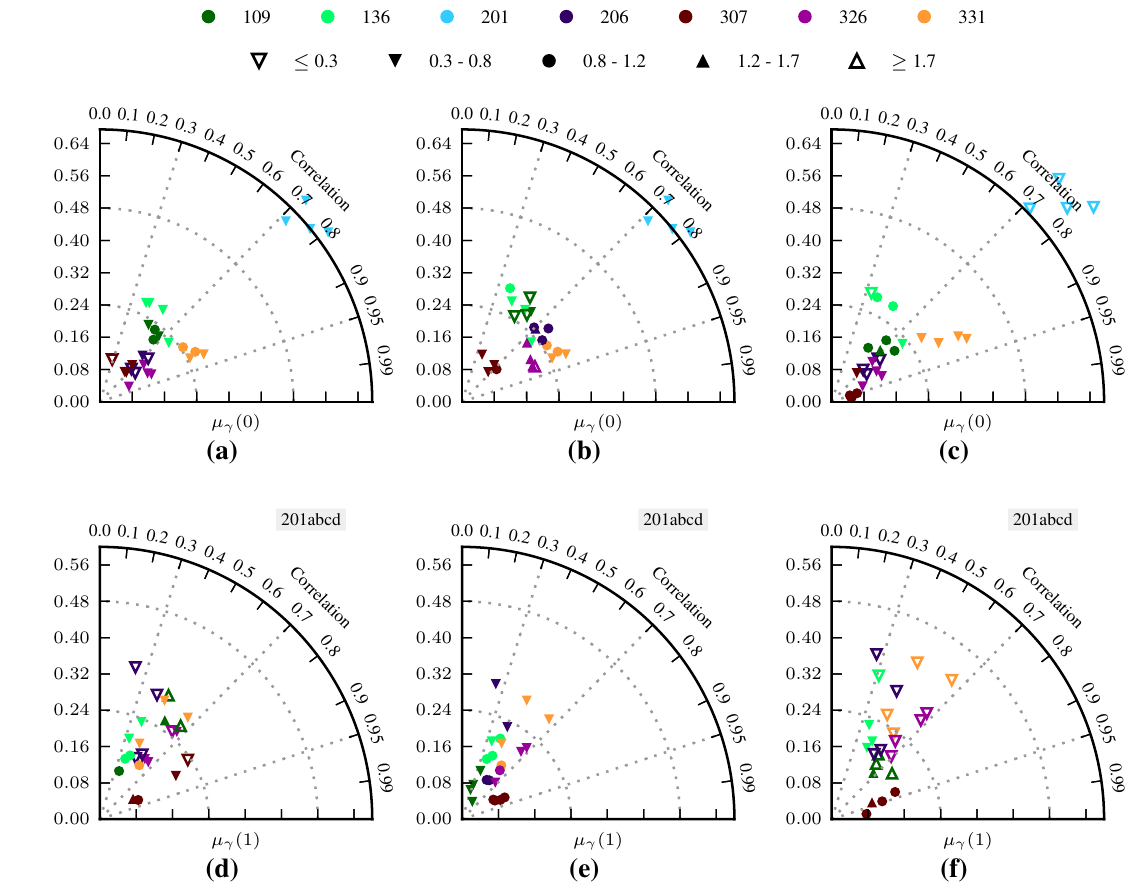
Figure 6. Taylor plots for HH polarization: the colour (symbol) encodes the field (sensitivity ratio) according to the legends on top. The angle gives the correlation ρ , the magnitude (distance from the origin) the misfit µ . Instances with negative correlations are not shown but listed in the grey box. The top panels give the relevant quantities for the phase φ (using different mixing models and ζ ), the bottom ones do the same for the coherence